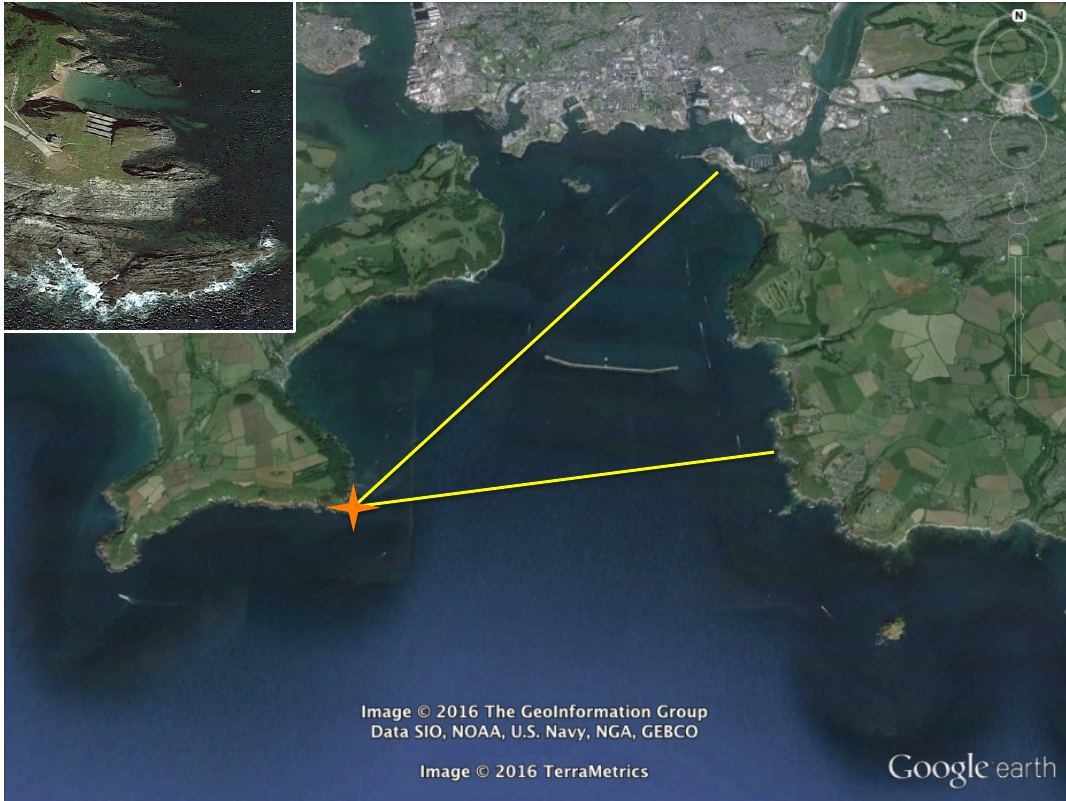
Figure 1. Location of Penlee Point Atmospheric Observatory (orange 4-point star). The yellow lines mark the air–water wind sector of 45 to 80 ◦ . The inset shows the area around the observatory (small hut in the left-centre of the